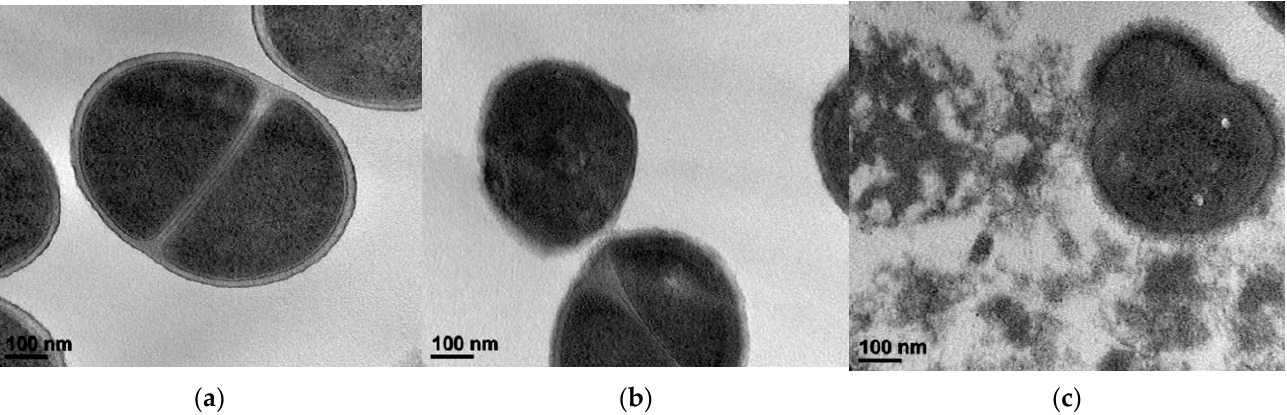
Figure 4. TEM images of MRSA (ATCC 33591) after treatment with SGB. ( a ) Untreated control MRSA. ( b ) MRSA treated with 1/2 MIC of SGB (6.3 μ g/mL). ( c ) MRSA treated with the MIC of SGB MRSA. ( b ) MRSA treated with 1/2 MIC of SGB (6.3 µ g/mL). ( c ) MRSA treated with the MIC of SGB (12.5 μ g/mL). (12.5 µ g/mL).